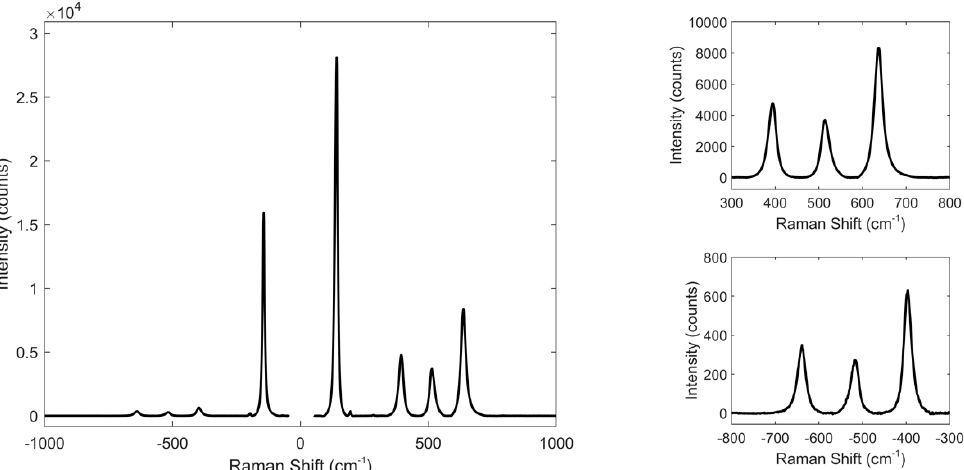
Figure 3. Stokes (positive Raman shift) and anti-Stokes (negative Raman shift) Raman spectrum of TiO 2 anatase recorded at 488.0 nm, with input power of 1.6 mW. In the right panel the zooms of the three less intense peaks are displayed, Stokes in the upper part, anti-Stokes in the lower one.